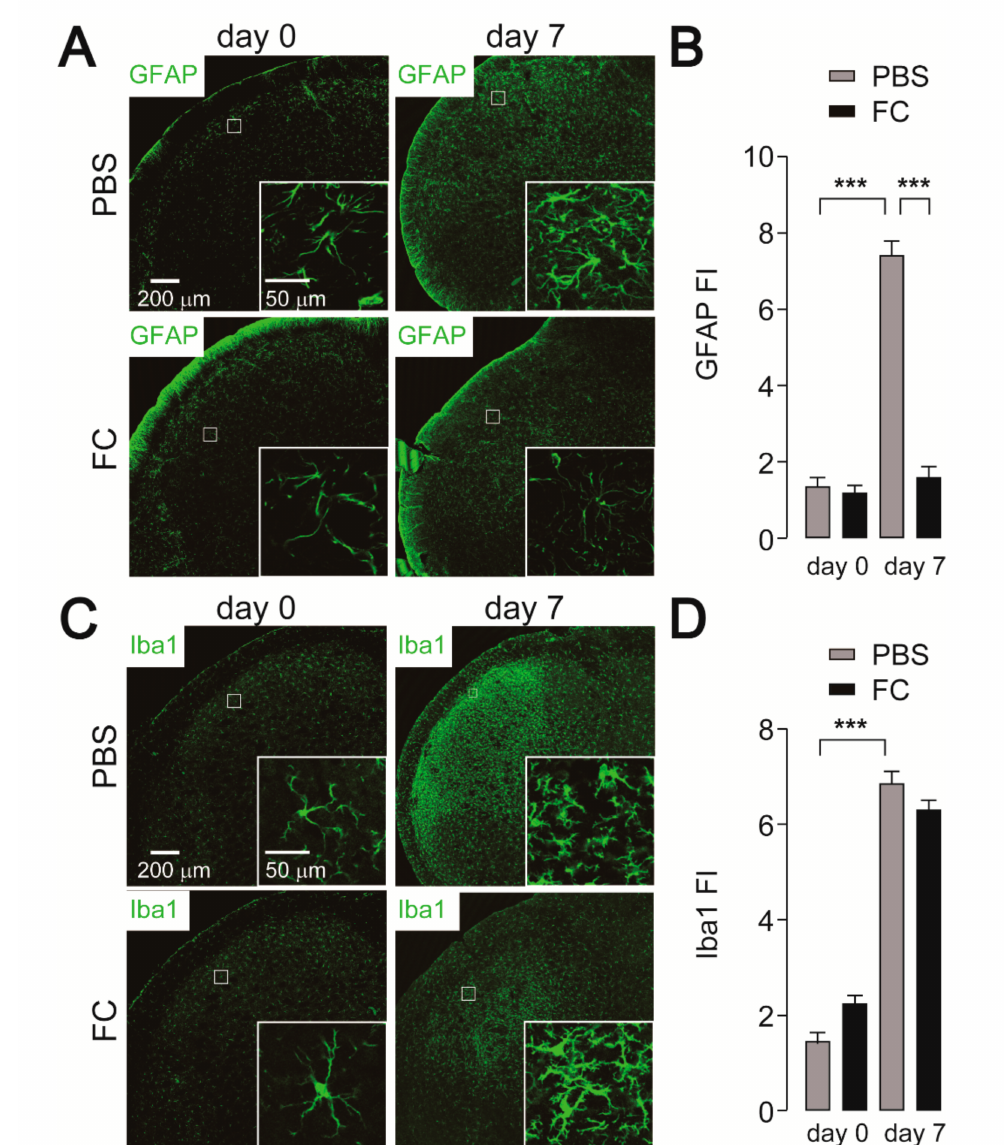
Figure 3. E ff ect of fluoroacetate on cellular activation of astrocytes and microglia in the Vc following IONI. ( A ) Representative images of GFAP immunofluorescence in the Vc. Insets indicate enlarged images of the region indicated in the open square. ( B ) GFAP fluorescence intensity (FI) in the Vc of saline or fluorocitrate (FC)-treated rats 0 and 7 days after IONI. PBS (day 0): n = 5, FC (day 0): n = 5, PBS (day 7): n = 5, FC (day 7): n = 5, two-way ANOVA followed by Tukey’s multiple comparison test, *** p < 0.001. ( C ) Representative images of GFAP immunofluorescence in the Vc. Insets indicate enlarged images of the region indicated in the open square. ( D ) Iba1 FI in the Vc of saline or FC-treated rats 0 and 7 days after IONI. PBS (day 0): n = 5, FC (day 0): n = 5, PBS (day 7): n = 5, FC (day 7): n = 5, two-way ANOVA followed by Tukey’s multiple comparison test, *** p < 0.001. The data represent the means ±